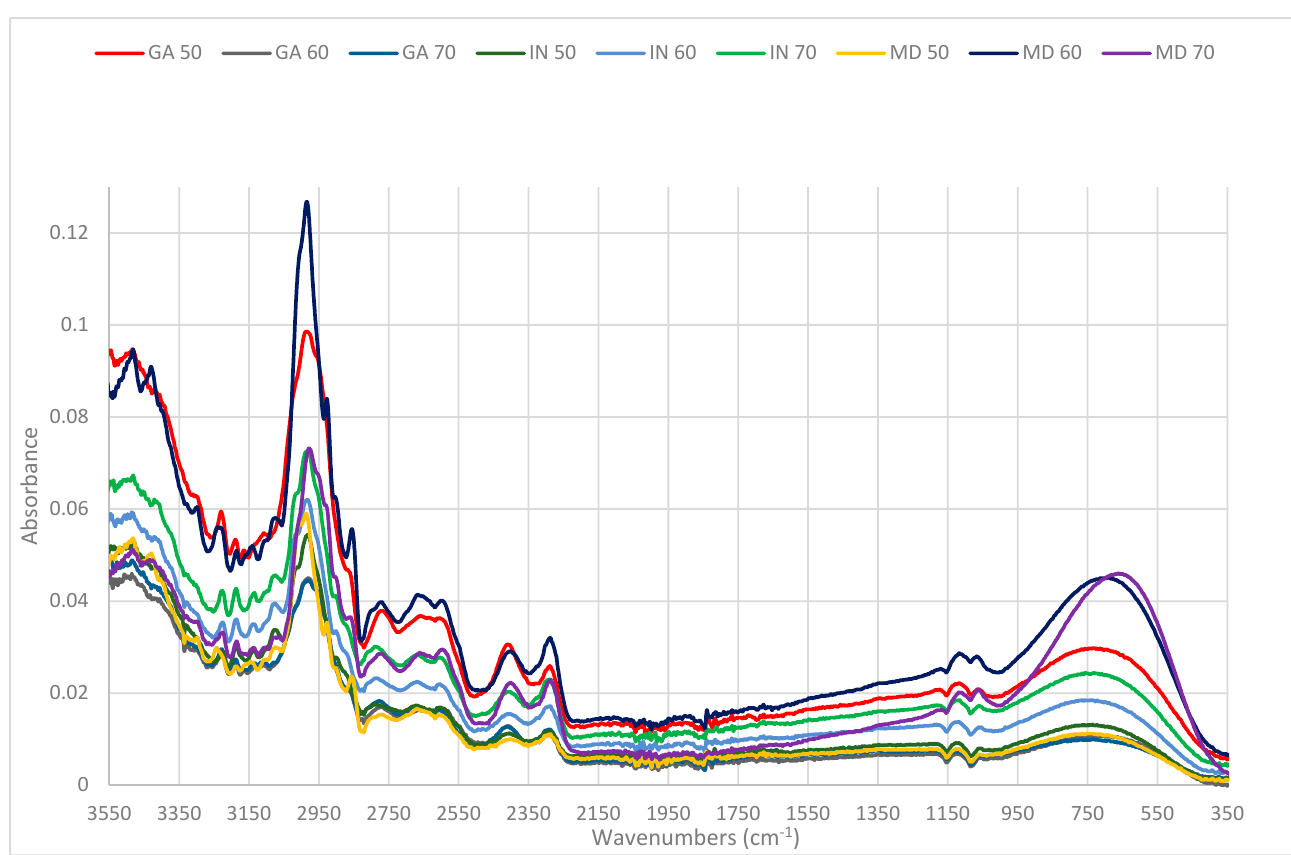
Figure 3. Spectrum in absorbance function for nine research trails.